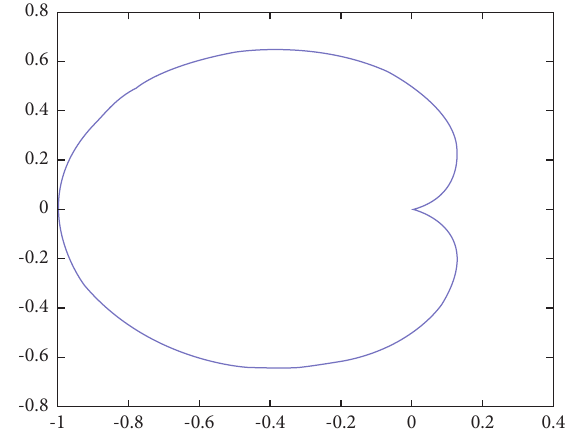
Figure 4: The boundary of the fixed point for P